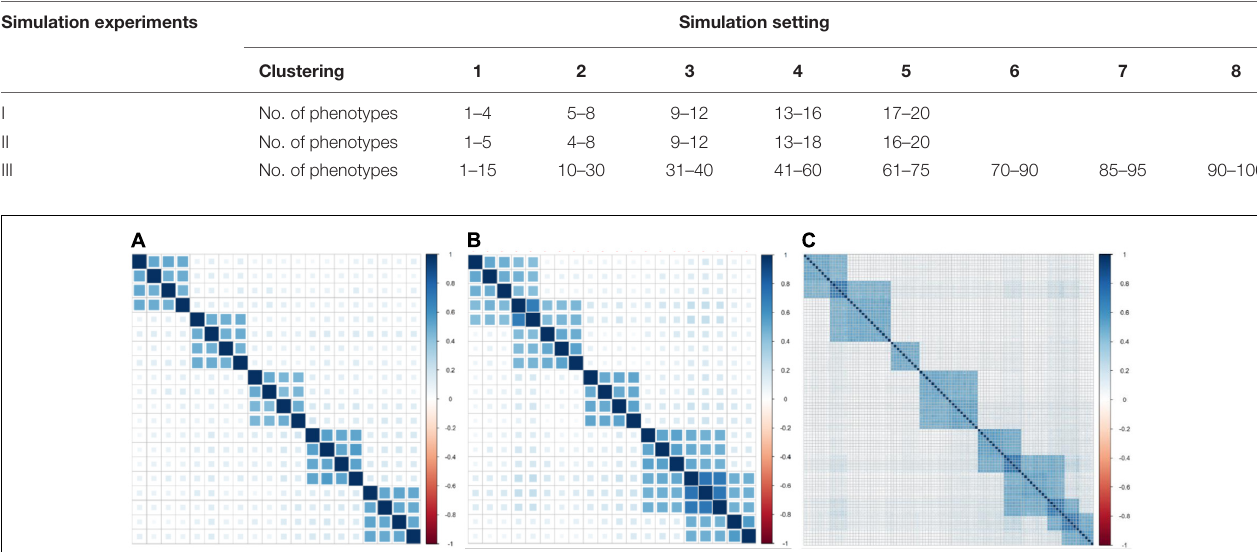
FIGURE 1 | Genetic correlations for three simulation experiments. (A) Five independent clusters (simulation I). (B) Five dependent clusters (simulation II). (C) Eight dependent clusters of high-dimensional phenotypes (simulation III).